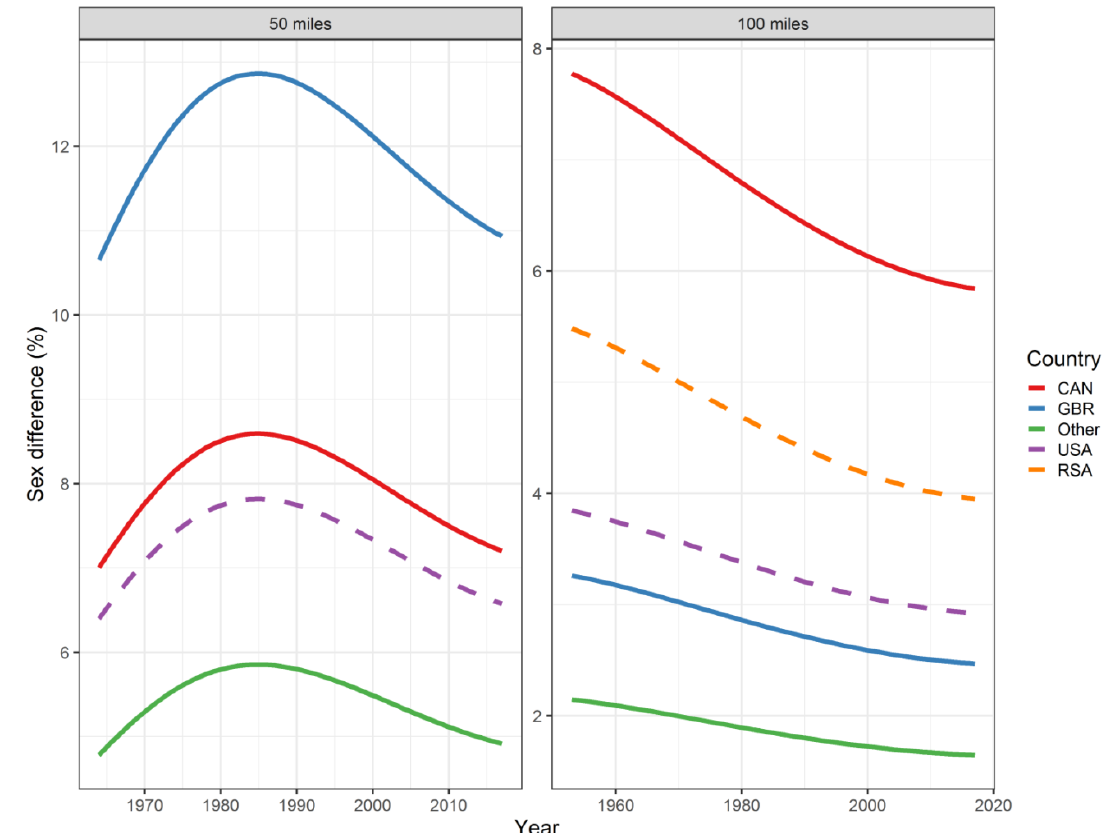
Figure 6. Sex di ff erences by calendar year and country in 50-mile and 100-mile ultra-marathons. Curves represent fitted values. For 50-mile races, South Africa was combined with other countries. USA = United States of America, CAN = Canada, GBR = Great Britain, RSA = Republic of South Africa, W = women, M = men. Sex di ff erences (%) in performance were defined as 100 × (women’s race time–men’s race time) / men’s race time .